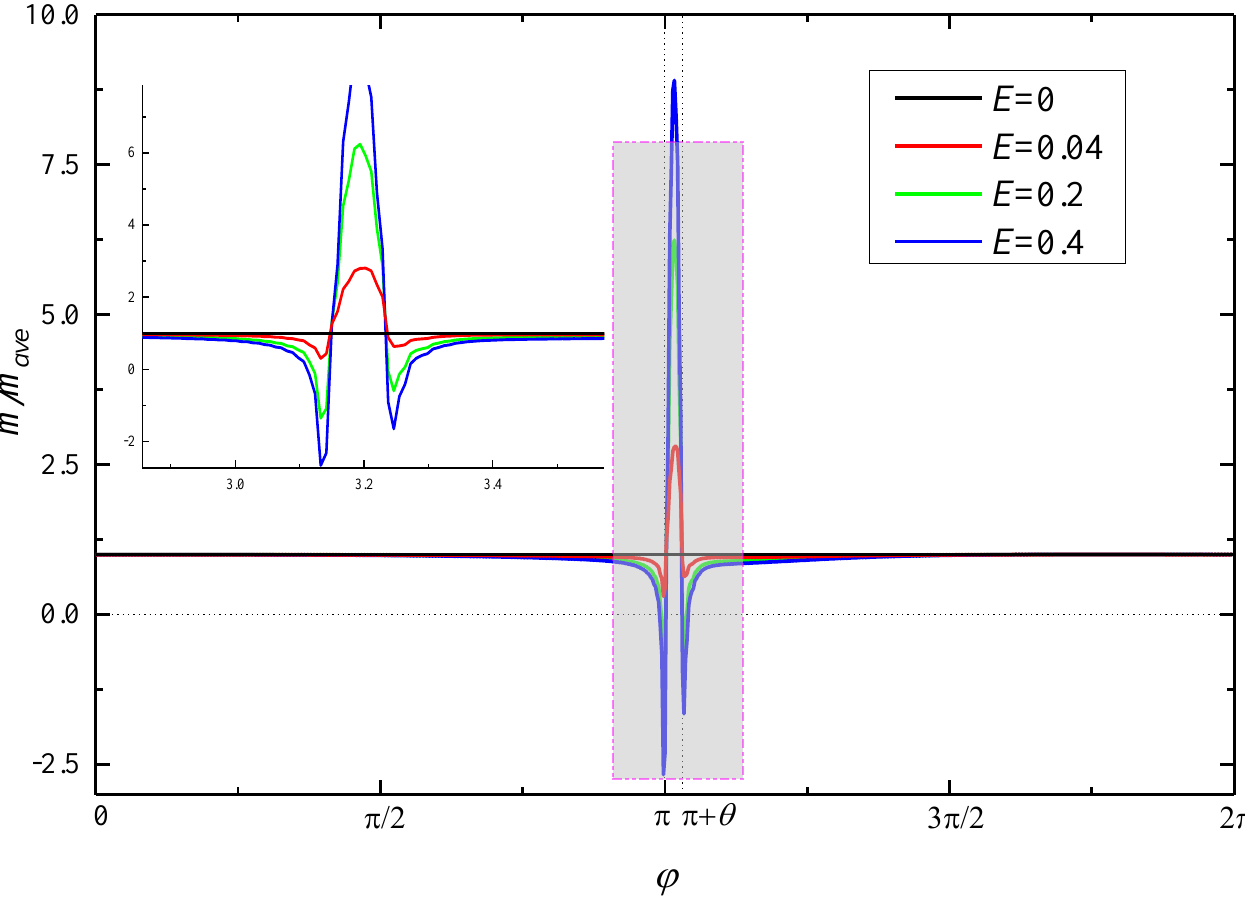
= 10,137 , 𝑅𝑒 = 5.12 × 10 5 , 𝜃 = 0.1 at r / b = 1. Figure 15. Distribution of mass flow rate for C w = 10,137, Re ϕ = 5.12 × 10 5 , θ = 0.1 at r / b = 𝑤 𝜑